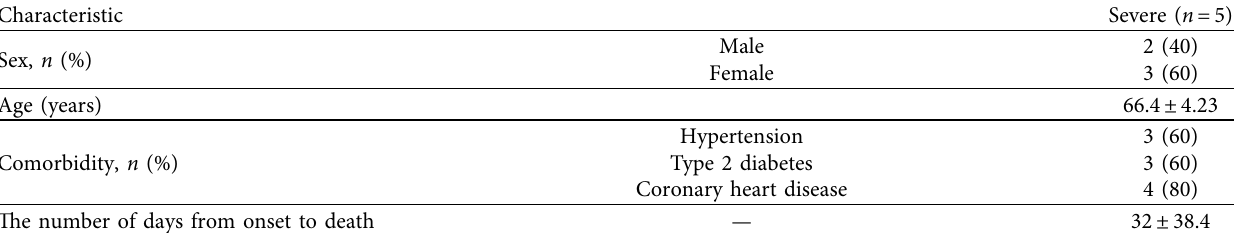
Figure 1: Flow chart of inclusion and exclusion criteria for patients with COVID-19 in this study. COVID-19, coronavirus disease 2019; CT, computed tomography. Table 1: Basic information and symptoms of the deceased patients.